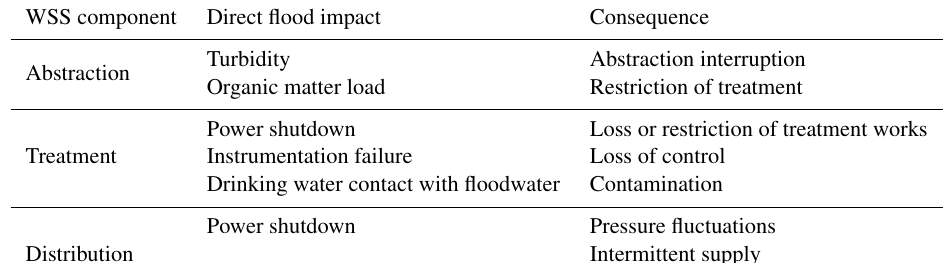
Table 1. Main impacts associated with flooding for WSS based on surface water source.